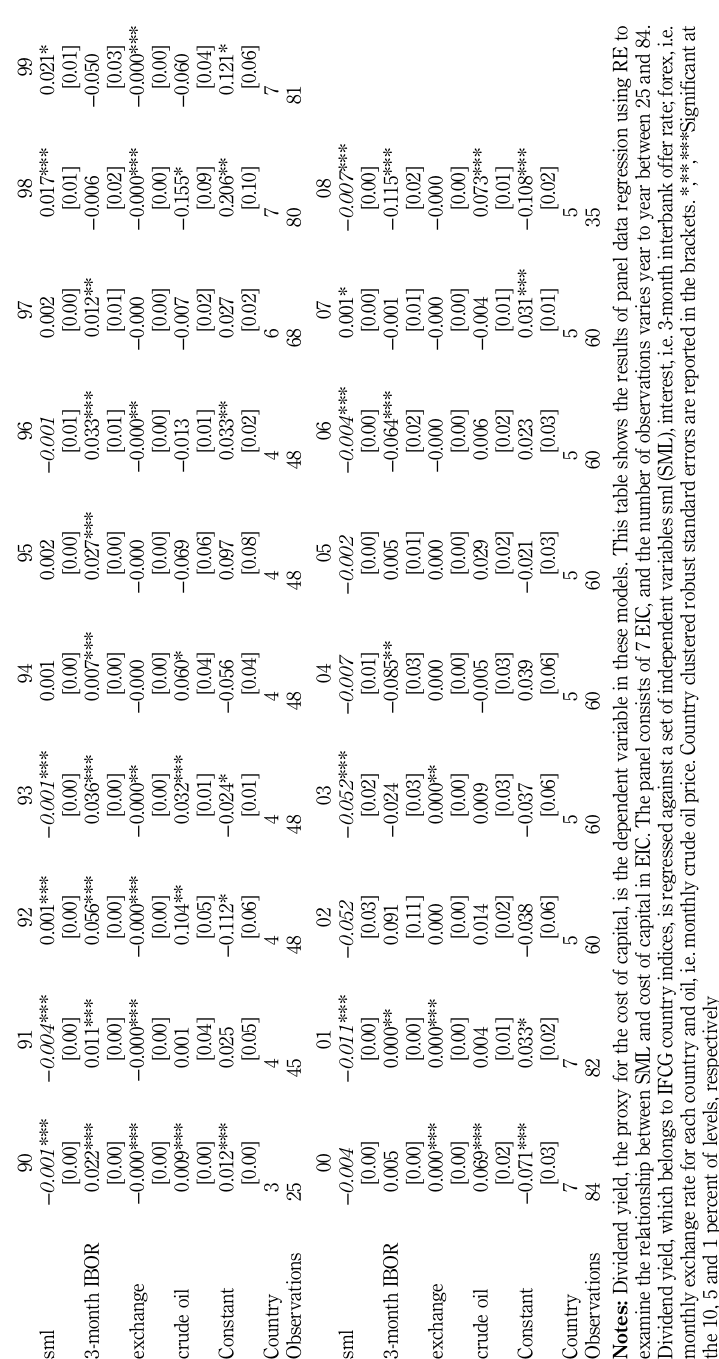
econometric model